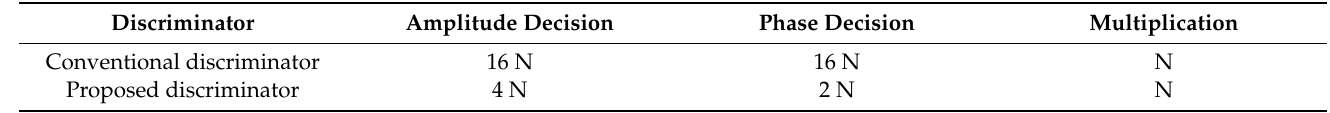
Table 2. Complexity comparison of the two discriminators for 16-APSK